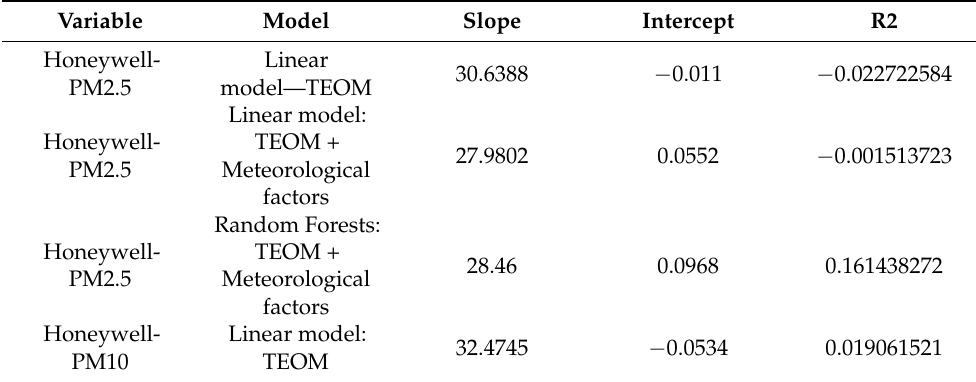
Table A1. Linear and Random Forests model results between COTS sensor PM measurement and TEOM PM values, with and without meteorological